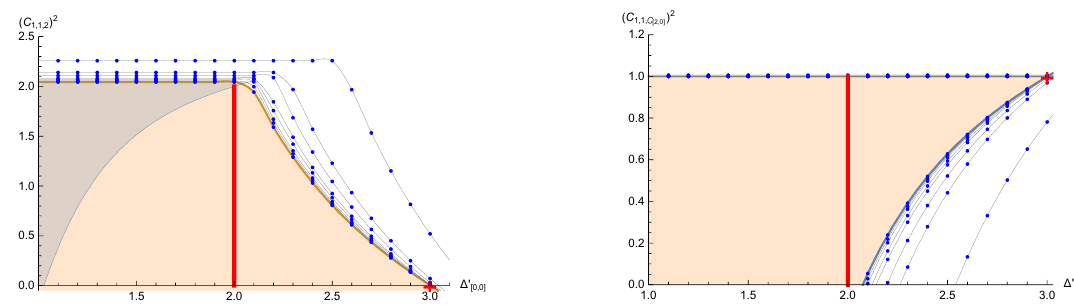
Figure 5 . Left: the bounds on C 2 as a function of (cid:1) 0 if the semi-short C is present. Right: [2 ; 0] 1 ; 1 ; 2 [0 ; 0] the bounds on C 2 as a function of (cid:1) 0 . The numerics are done for (cid:3) = 10 ; 20 ; : : : ; 80 and 1 ; 1 ; C [2 ; 0] [0 ; 0] the allowed regions for (cid:3) = 80 are shaded in orange. Analytic solutions from (C.1) are marked in red. For the purpose of comparison, we overlay in light blue on the left the allowed region of (cid:12)gure 6. One must keep in mind that if C decouples, we can identify (cid:1) 0 with (cid:1) here, [2 ; 0] [0 ; 0] [0 ; 0] since we consider a single gap in the long